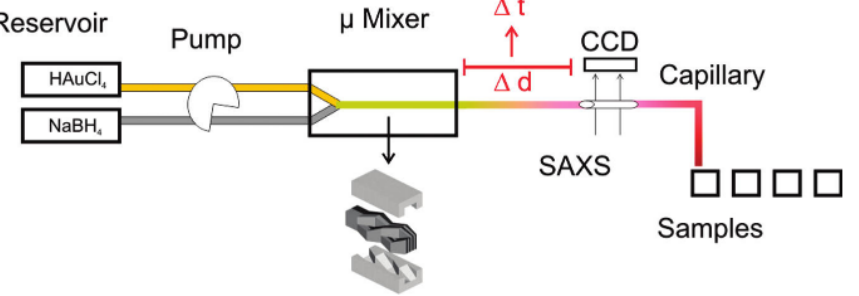
Figure 11. Experimental setup for the synthesis of gold nanoparticles by using a static mixer coupled directly to SAXS-analysis in a flow cell [23].